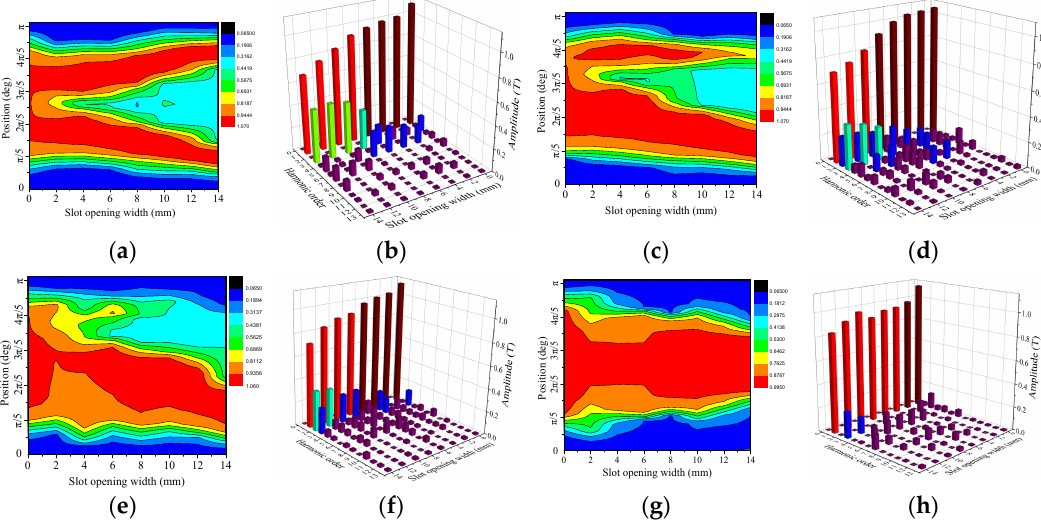
Figure 10. Air-gap magnetic field analysis of the DDPMM with 16 poles and 18 slots at different positions: ( a ) magnetic field distribution at position 1; ( b ) harmonics at position 1; ( c ) magnetic field distribution at position 2; ( d ) harmonics at position 2; ( e ) magnetic field distribution at position 3; ( f ) harmonics at position 3; ( g ) magnetic field distribution at position 4; ( h ) harmonics at position 4.